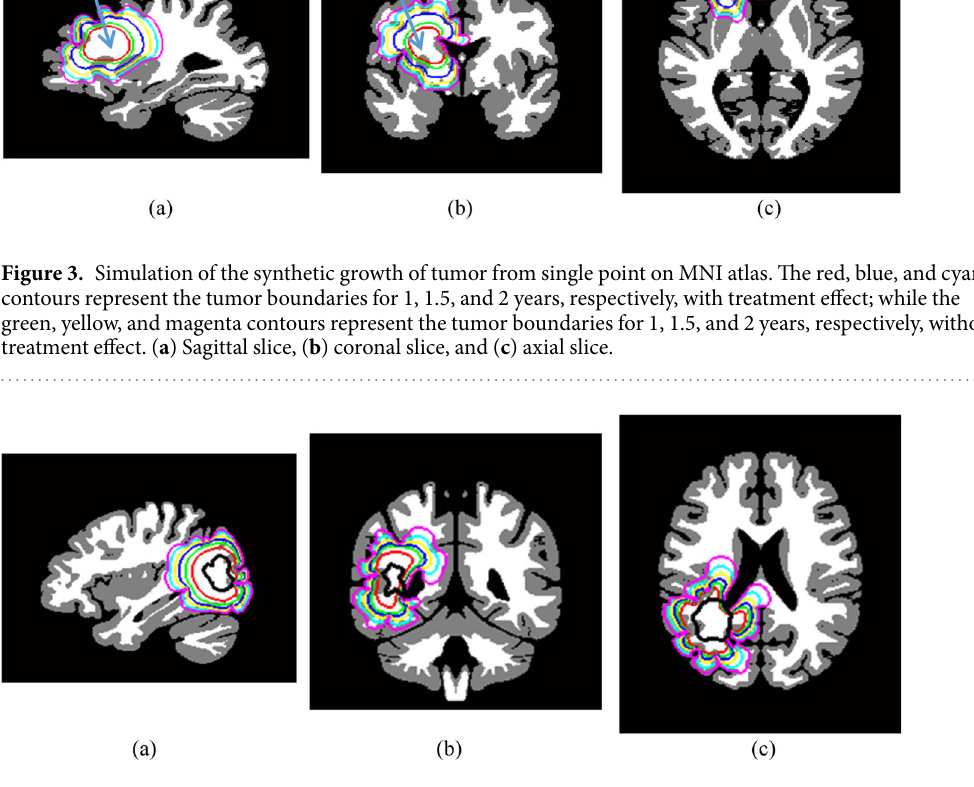
Figure 4. Simulation of the synthetic growth of real LGG seeded into the MNI atlas represented in the dark black color. The red, blue, and cyan contours represent the tumor boundaries for 1, 1.5, and 2 years, respectively, with treatment effect; while the green, yellow, and magenta contours represent the tumor boundaries for 1, 1.5, and 2 years, respectively, without treatment effect. ( a ) Sagittal slice, ( b ) coronal slice, and ( c ) axial